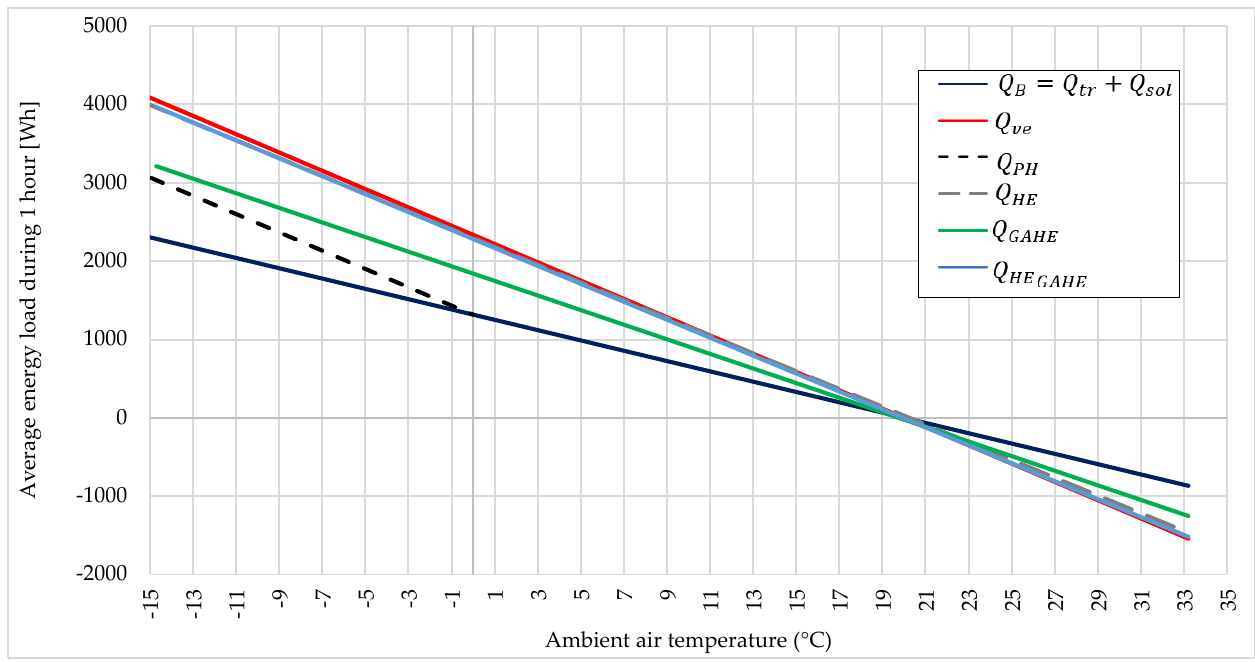
Figure 4. Boundary values of hourly energy loads [Wh] in the entire building at different ambient temperatures—maximum heating energy load and minimum cooling energy load in all systems.